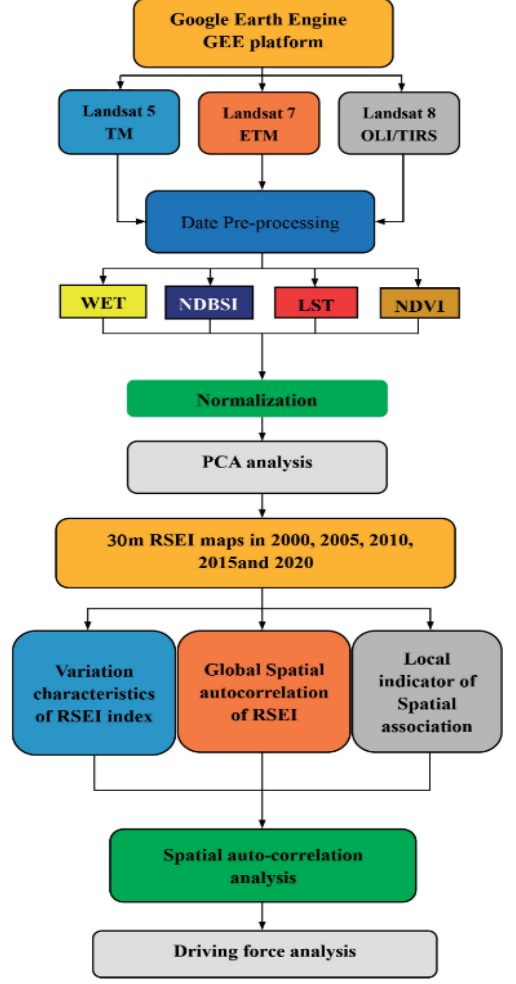
Figure 2. Workflow chart demonstrating the ecological quality in the Kuye River .